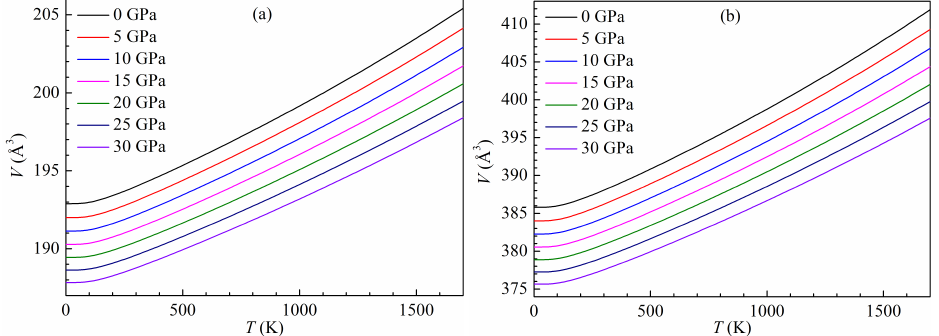
Figure 14. Temperature dependence of volume V for the LPSs ( a ) h- and ( b ) r-Al 2 Ti under pressure up to 30